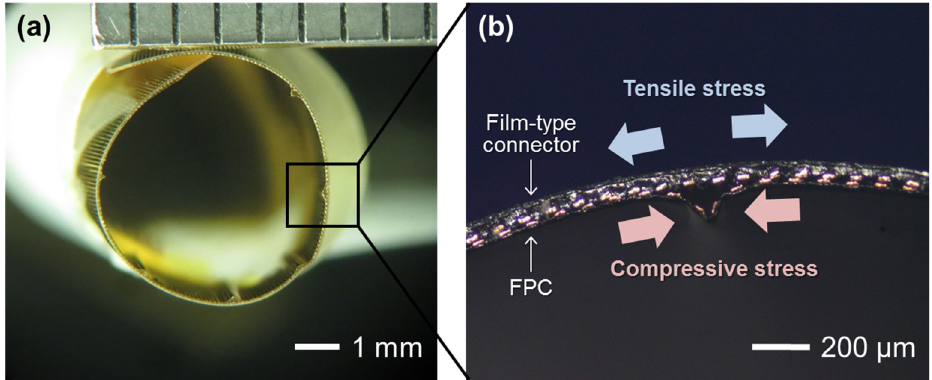
Figure 18. Cross-sectional image of the junction of the film-type connection: ( a ) complete image of the junction and ( b ) enlarged image of a